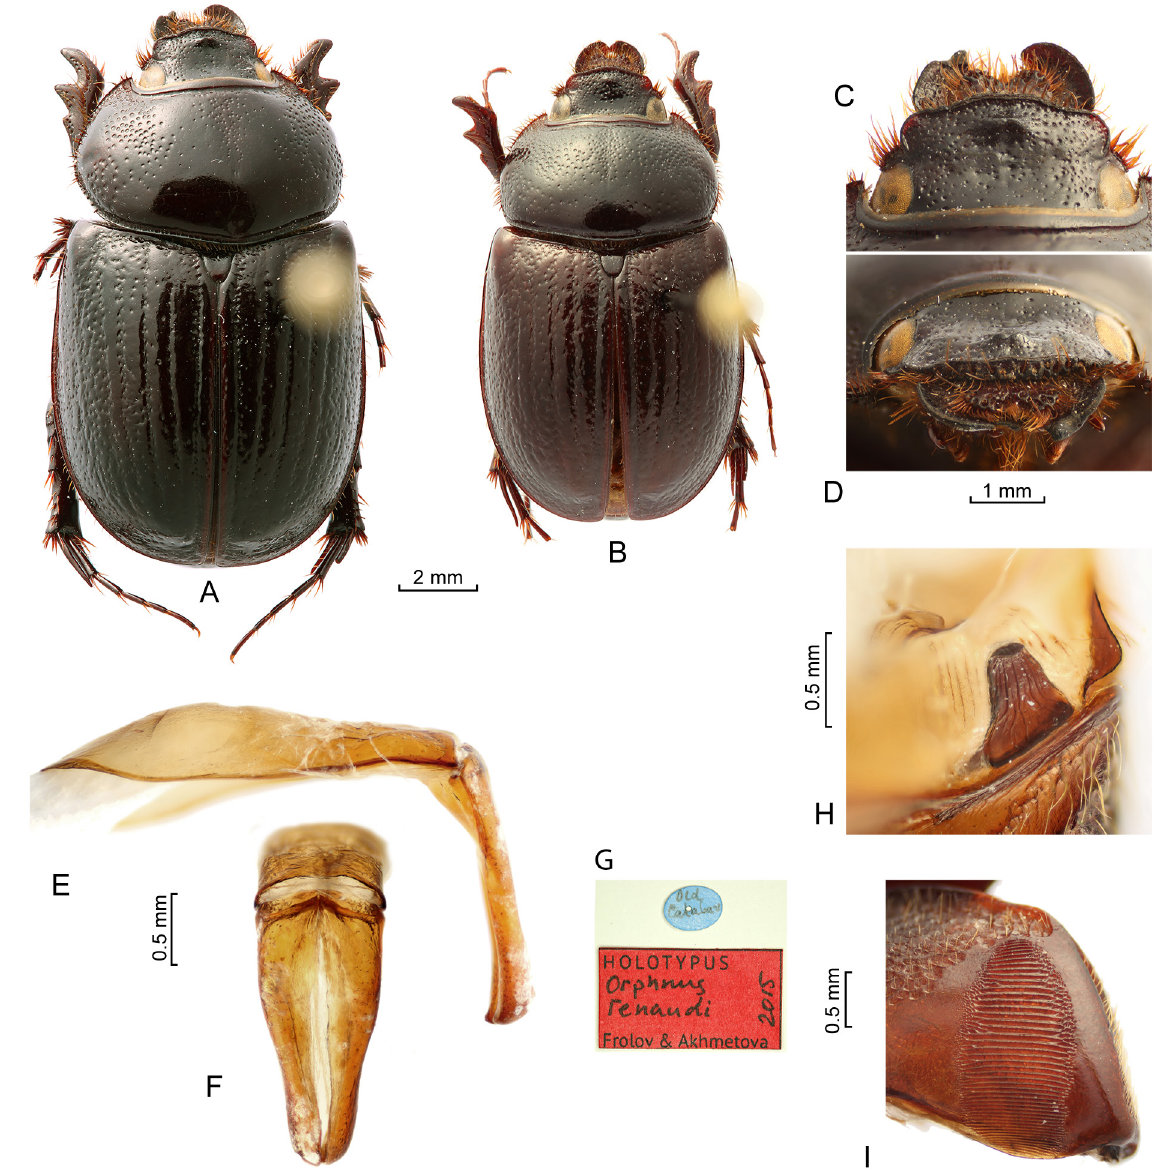
Fig. 2. Orphnus renaudi sp. nov. A–B . Habitus. C–D . Head in dorsal and apical view. E . Aedeagus in lateral view. F . Parameres in dorsal view. G . Labels of holotype. H . Abdomen in dorsal view. I . Stridulatory field. A, C–D, G. Holotype. B, E–F, H–I.